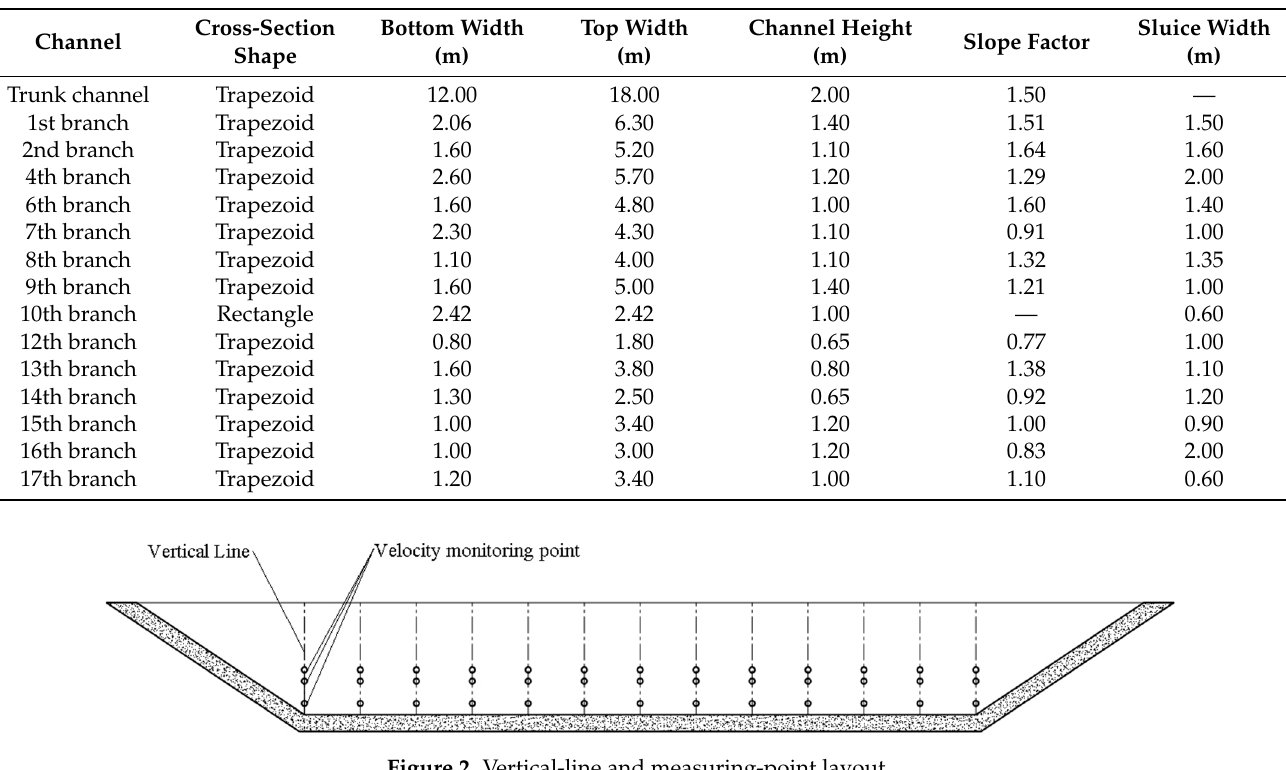
Figure 2. Vertical-line and measuring-point layout.